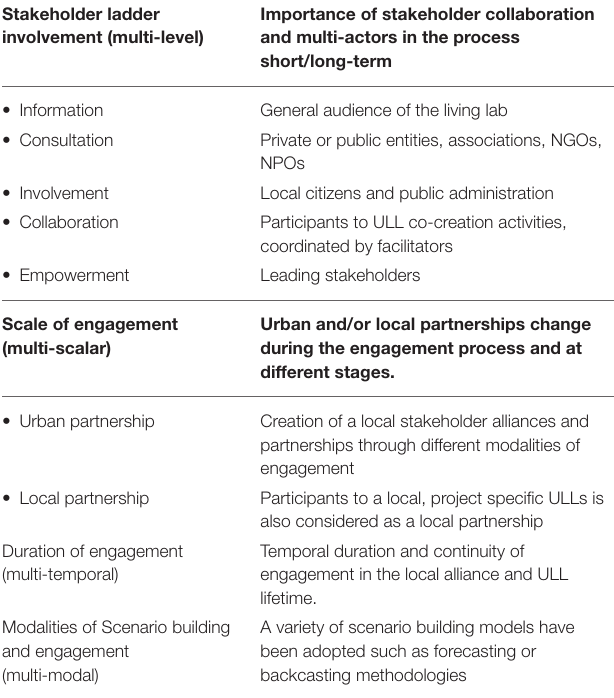
TABLE 4 | Stakeholder engagement mechanisms (multi-level/multi- scalar/multi-modal). Stakeholder ladder involvement